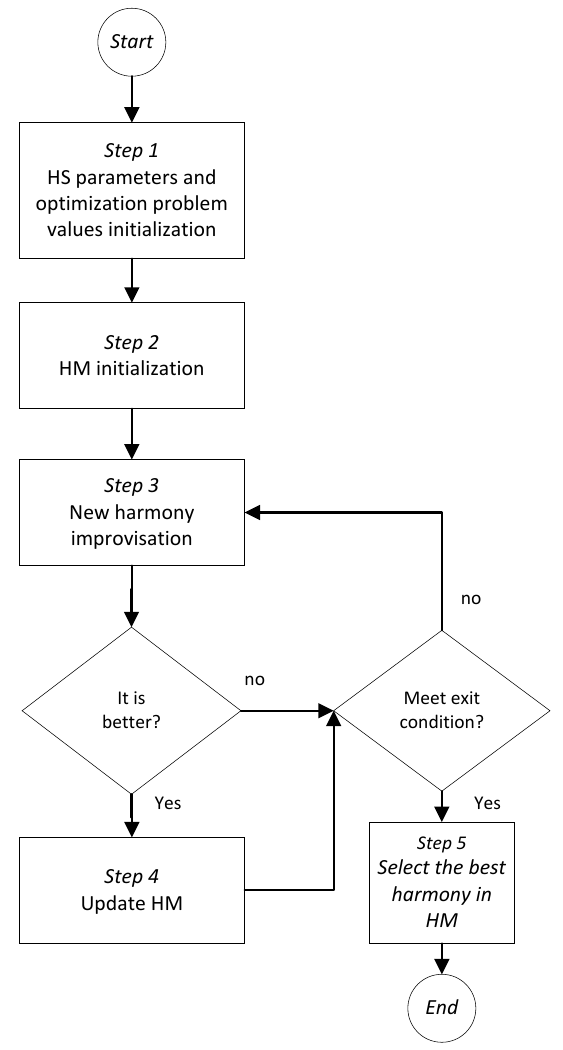
Figure 2. Flowchart of the implemented HS